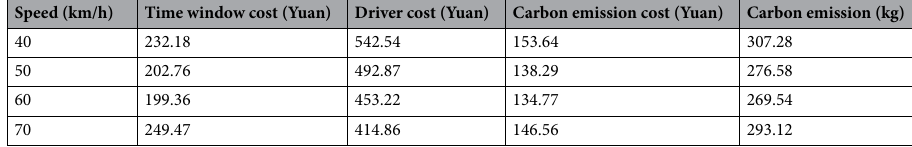
Table 4. The effect of various